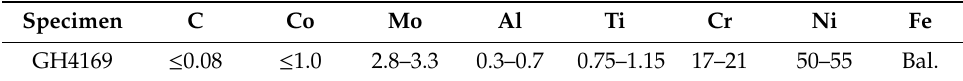
Figure 1. The schematic diagram of reciprocal sliding friction device. Table 1. Chemical composition of GH4169 superalloy (wt%).